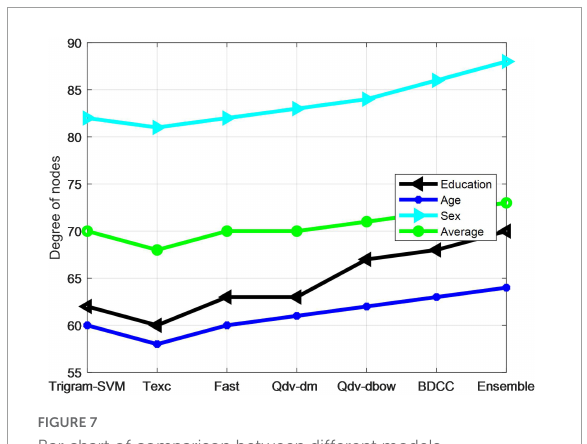
FIGURE7 Bar chart of comparison between different models.